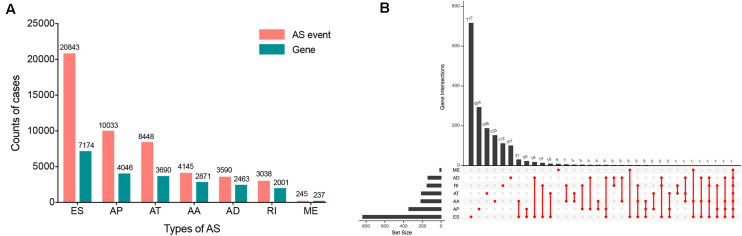
Overview of seven types of AS in this study. (A) Number of AS events and related genes in ESCA. (B) UpSet plots in ESCA, showing the interactions among the seven types of OS-associated AS events. One gene may have up to seven types of AS events.